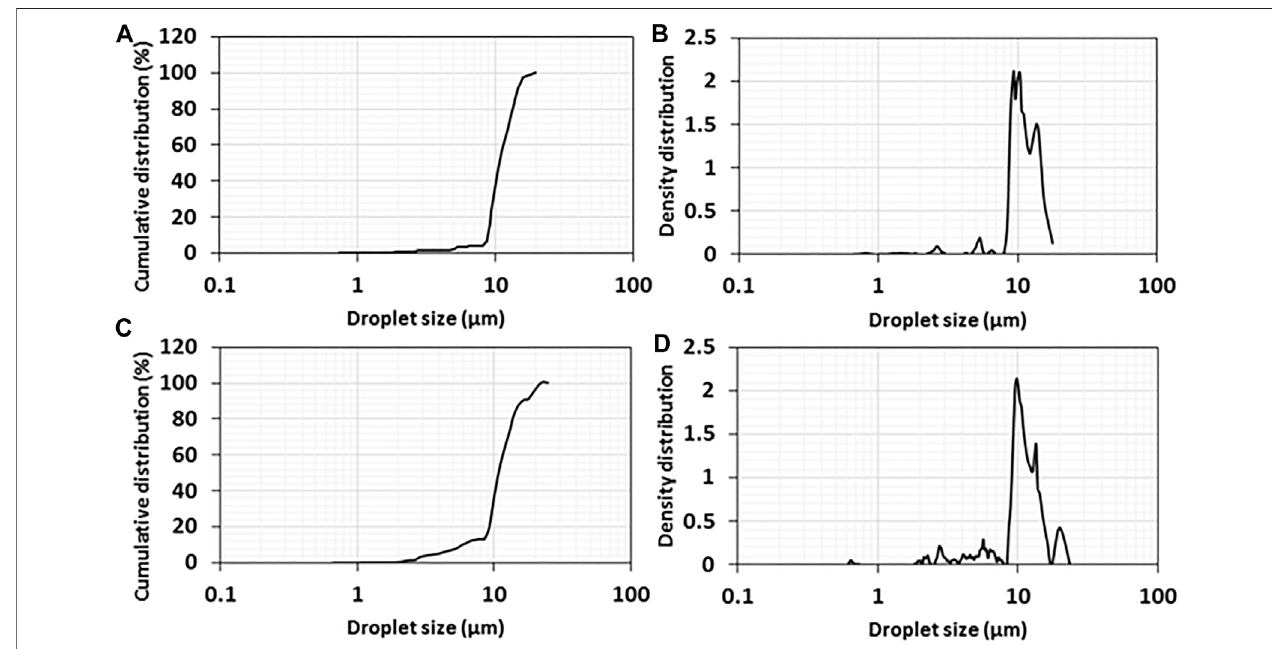
FIGURE4| CumulativeanddensitydistributionsofoildropletsizesinPickeringemulsionswitha1wt%titania-NH 2 NPscontentat (A,B) 40:60and (C,D) 50:50oil/ water (vol%) ratios.